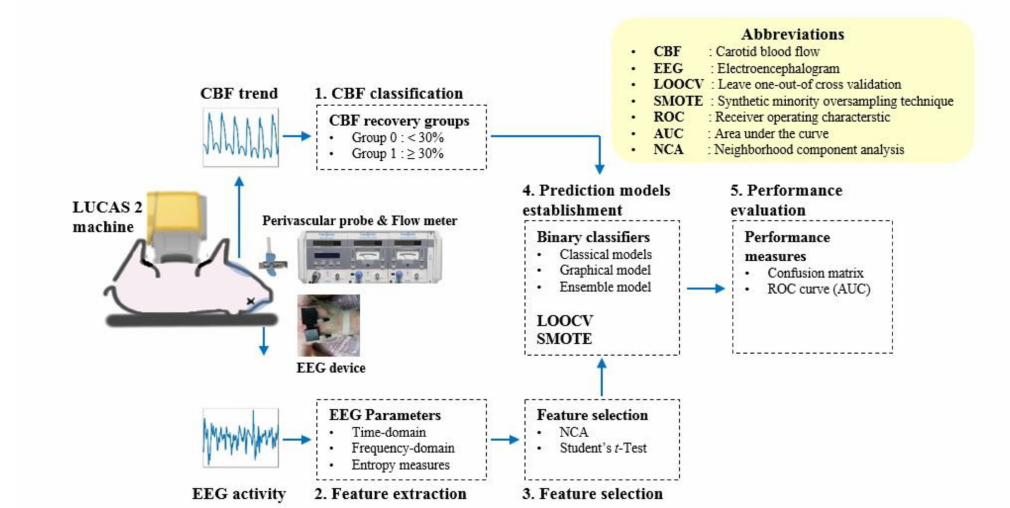
Figure 2. Total developmental stages of the prediction models; from animal experiments to performance evaluation: the frontal EEG and CBF data were acquired during the process of CPR. CBF recovery rates were calculated and categorized into two groups with a division criterion of 30%. Time- and frequency-domain EEG parameters and entropy endices were determined. The top 10 significant EEG parameters were selected through the NCA and Student’s t -Test. An EEG-based binary classifier for CBF recovery was established based on LOOCV and SMOTE methods. Finally, the performances of prediction models were evaluated with the confusion matrix and ROC